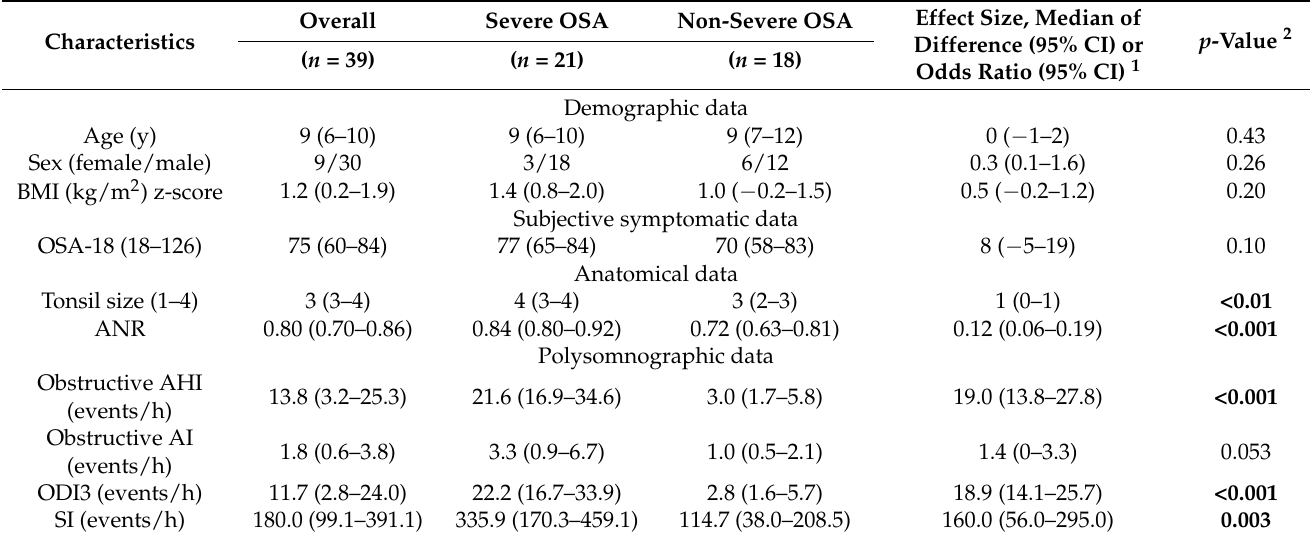
Table 1. Patients’ characteristics of Study